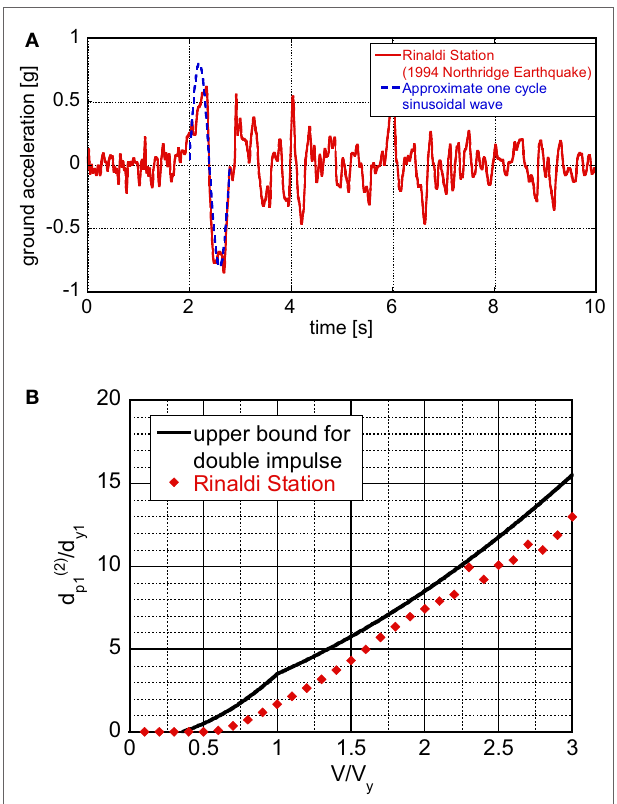
FigUre 23 | applicability to recorded ground motion: (a) Modeling of part of pulse-type recorded ground motion (Rinaldi station fault-normal component during the Northridge earthquake in 1994) into the corresponding one-cycle sinusoidal input: (B) Maximum amplitude of plastic deformation for the recorded ground motion and the proposed upper bound for the corresponding double